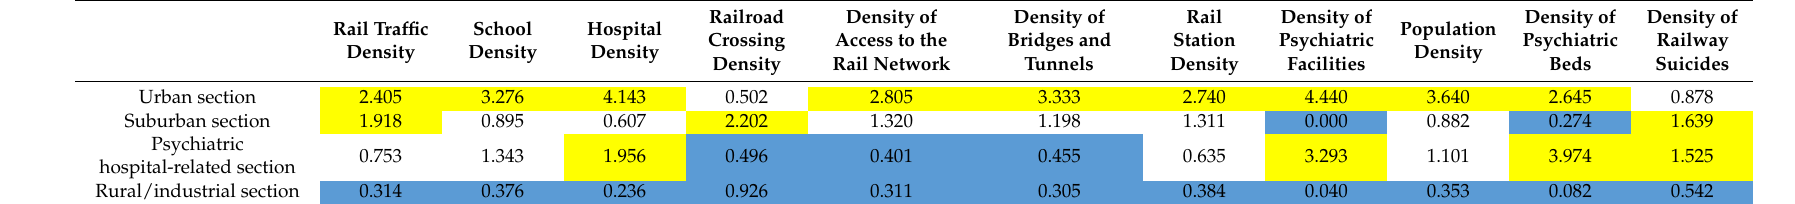
Yellow: statistically significant overrepresentation; blue: statistically significant underrepresentation; (significance threshold =